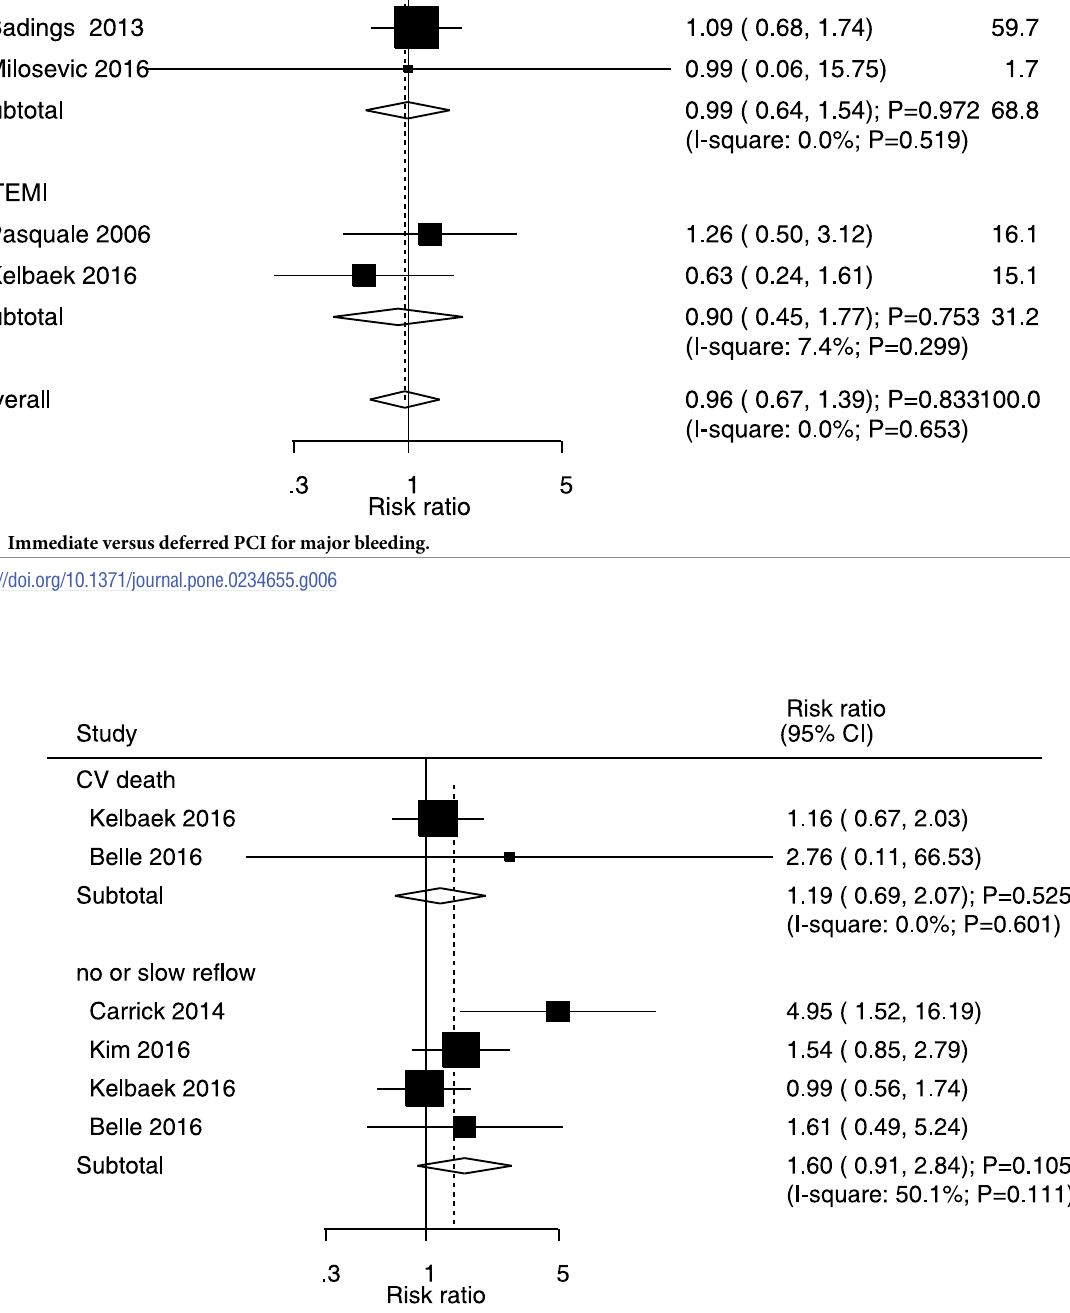
Fig 7. Immediate versus deferred PCI for cardiac death and no or slow reflow.